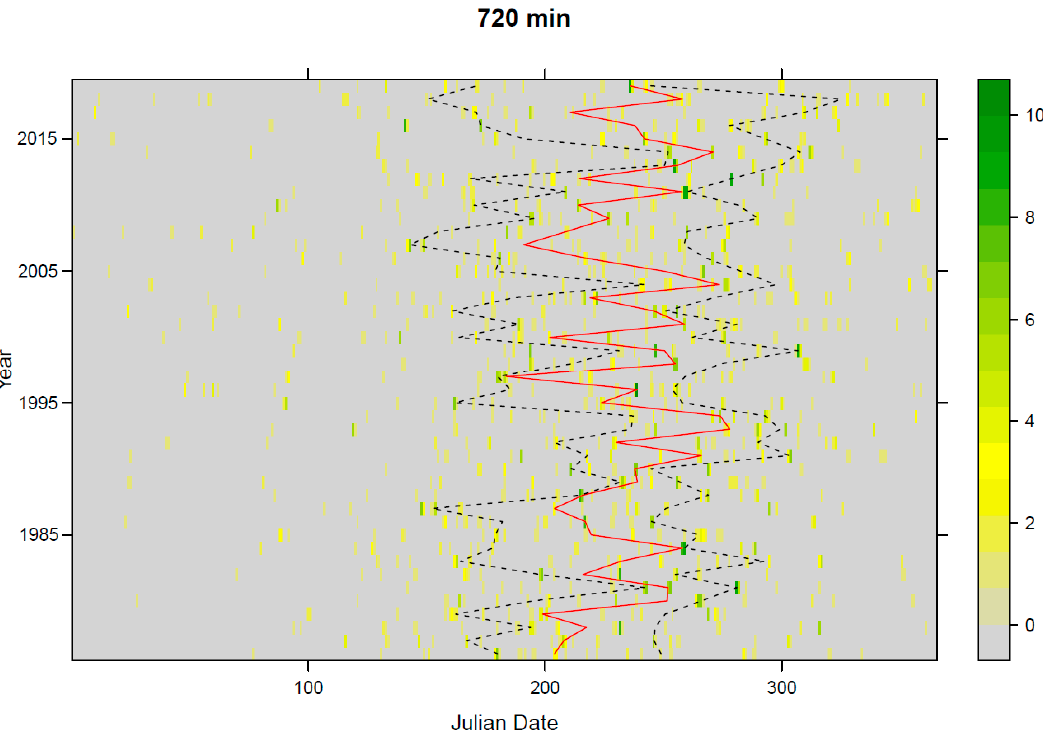
Figure 7. Clustering of the AM5 events for the 720 min rainfall duration. Red line shows the median Julian date and dotted black lines show 25% and 75% Julian date.